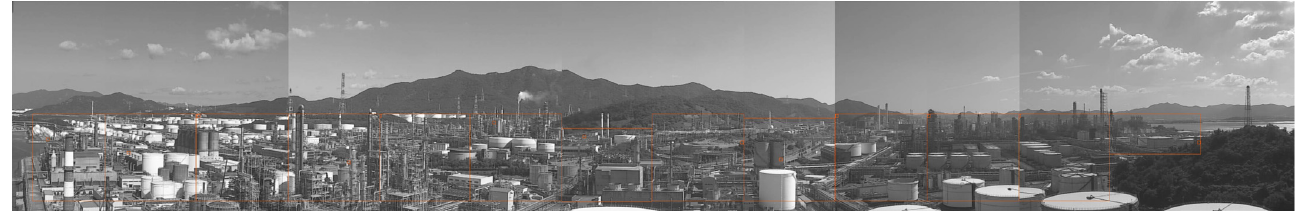
Figure 3. Program mode of the SIGIS-2 installed at the Jeongnyang site.